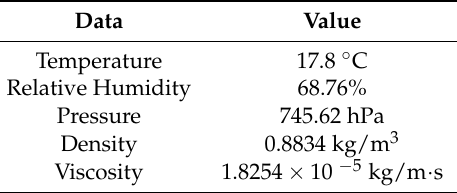
Table 3. Experimental air